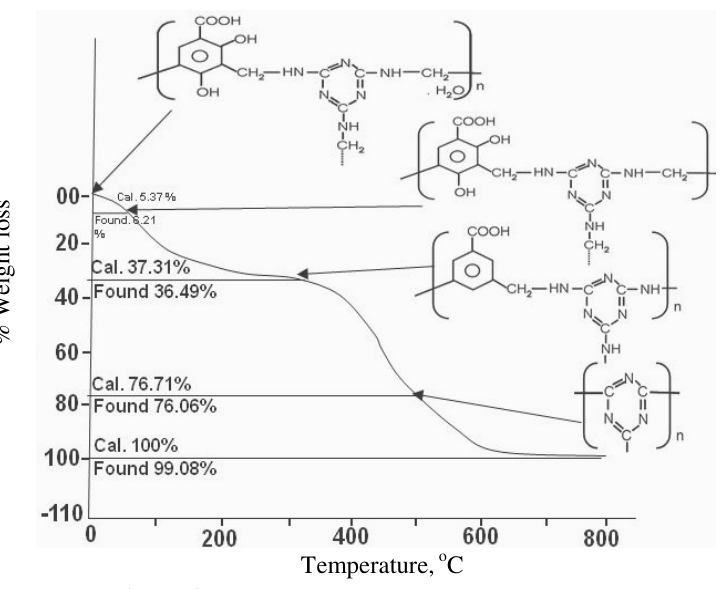
Figure 4. Thermogram of 2,4-DHBAMF copolymer. Table 2. Thermogravimetric data of 2,4-DHBAMF copolymer corresponding to heating rate of 10 0